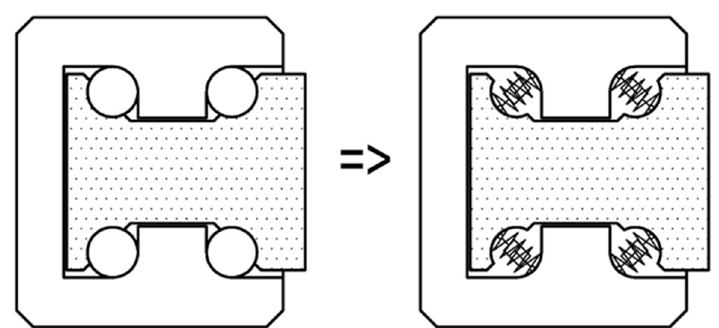
Figure 14. The substitution of rolling elements by elastic and damping connections.